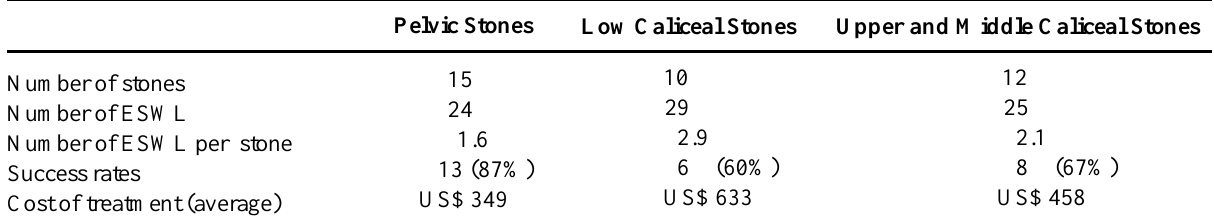
Table 3 – The outcome and cost of ESWL in the treatment of pelvicalyceal stones sized between 6 and 20 mm in morbidly obese patients according to the position of the stone in pelvicalyceal system